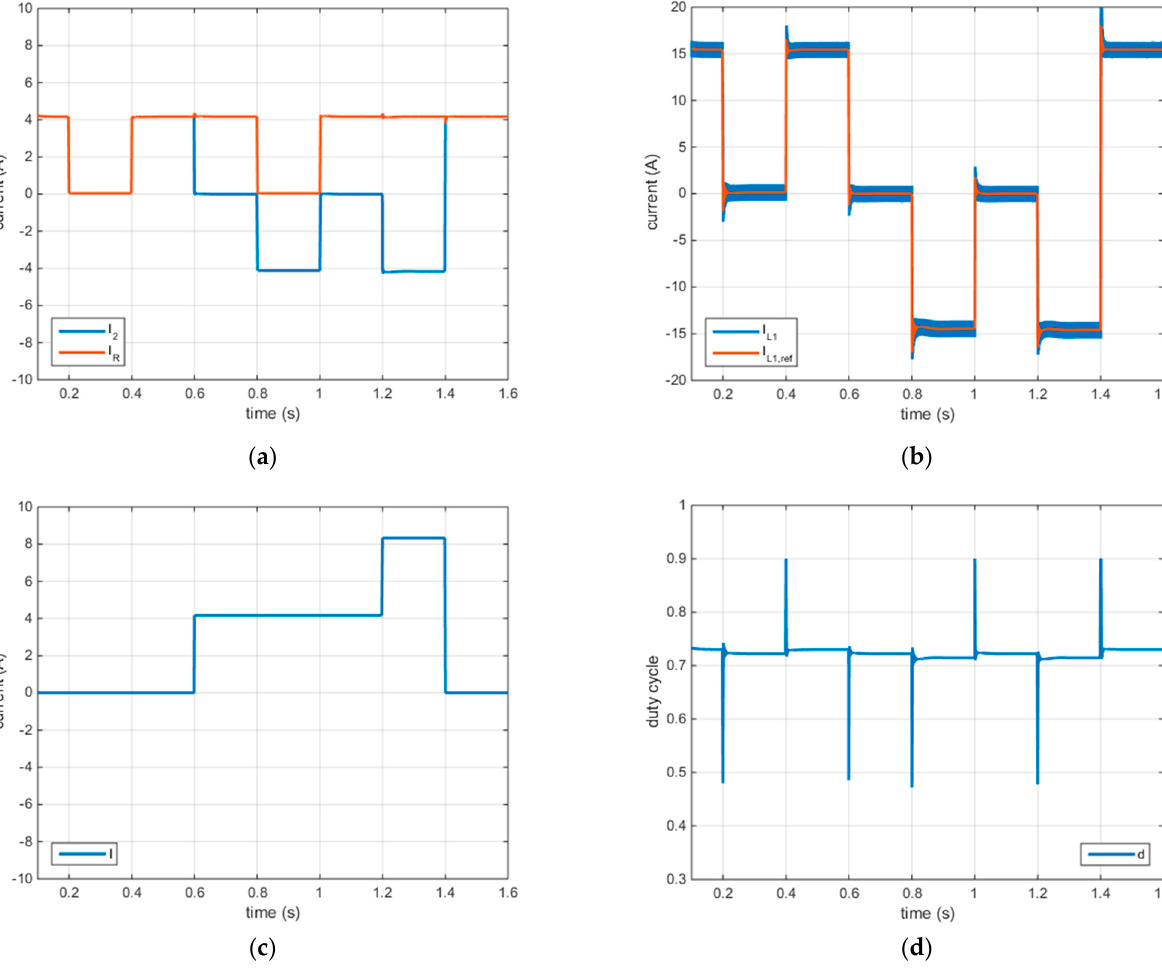
Figure 4. Performance obtained in scenario #1 (SS − GN): ( a ) output current and load current; ( b ) input inductor current; ( c ) external generator’s current; ( d ) duty cycle.